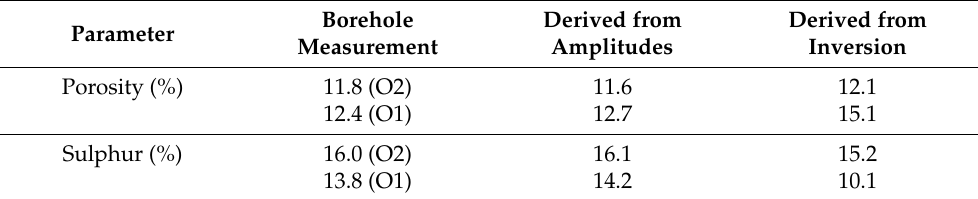
Derived from Inversion